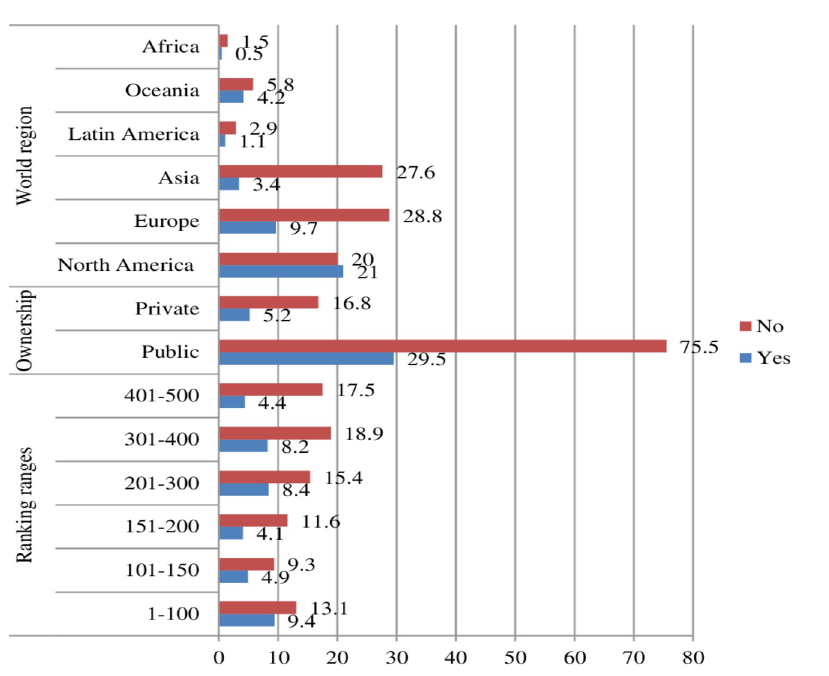
Fig 2. Average frequencies of universities that did or did not fulfil all institutionalisation indicators, in terms of ranking ranges, ownership and world region.